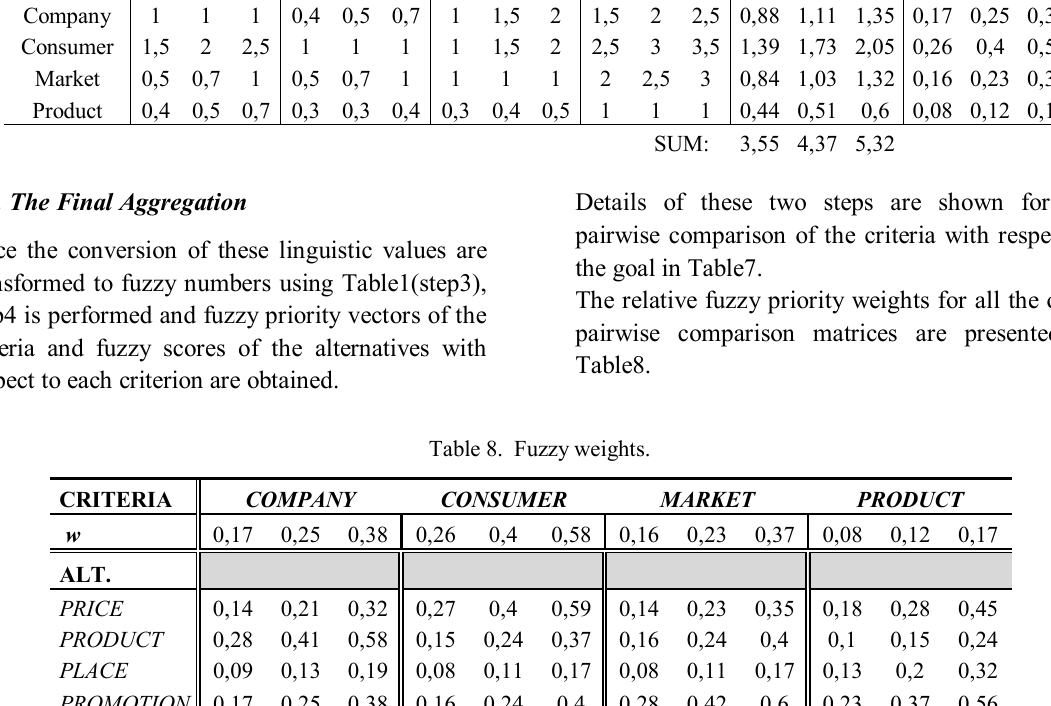
Relative Fuzzy Geom. Mean